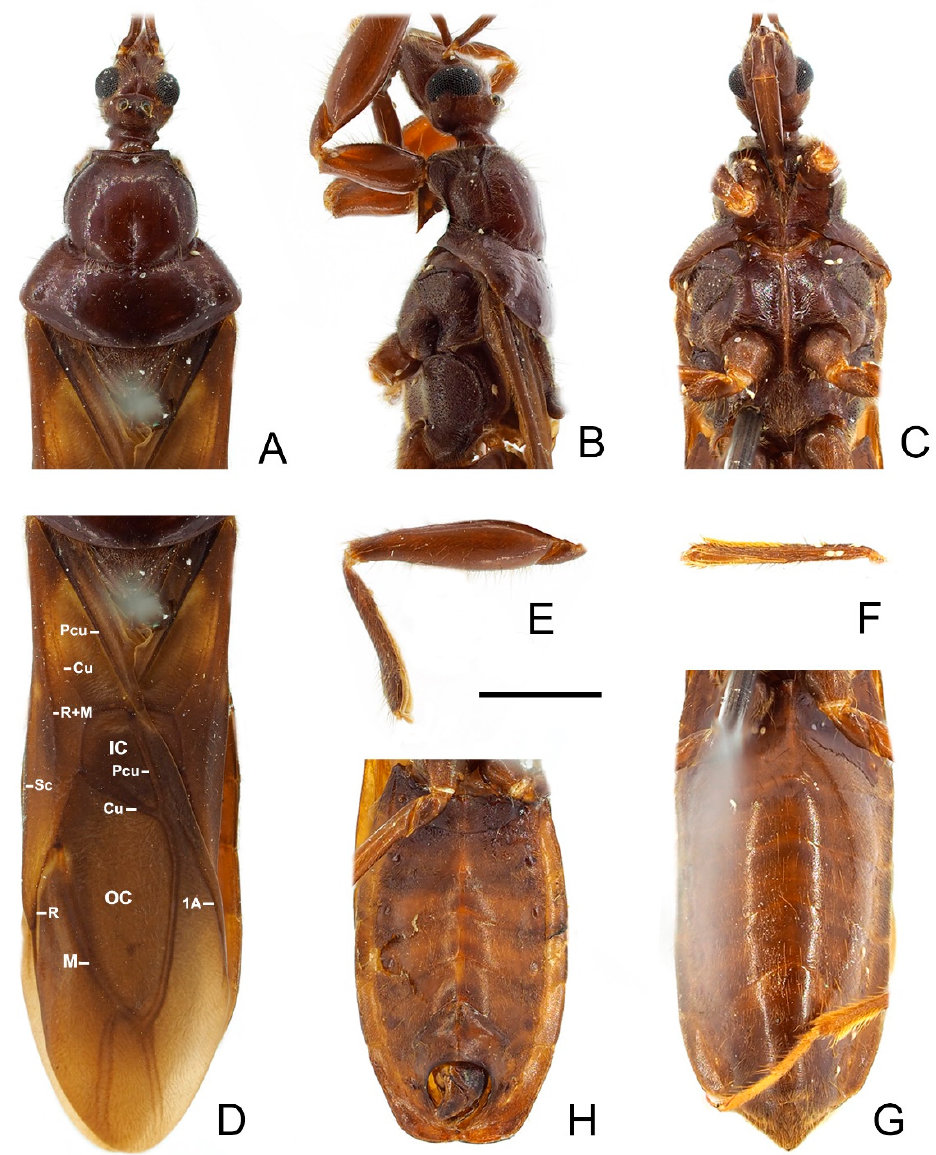
Figure 12. Sigicoris gracilis comb. nov. , paratypes. ( A ) Anterior part of body with antennae and legs removed, female, dorsal view; ( B ) ditto, lateral view; ( C ) ditto, ventral view. ( D ) Hemelytra, female, dorsal view. ( E ) Left fore leg without tarsus, female, ventral view. ( F ) Right mid tibia, female, ventral view. ( G ) Abdomen, female, ventral view. ( H ) Abdomen, male, ventral view. Scale bar = 2.00 mm.